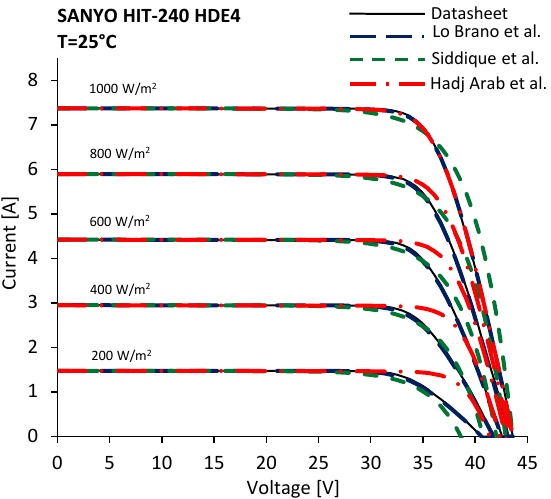
Figure 9. Comparison between the issued I-V characteristics of Sanyo HIT-240 HDE4 at T = 25 °C and the characteristics calculated by means of the Lo Brano et al ., the Siddique et al . and the Hadj Arab et al . models.